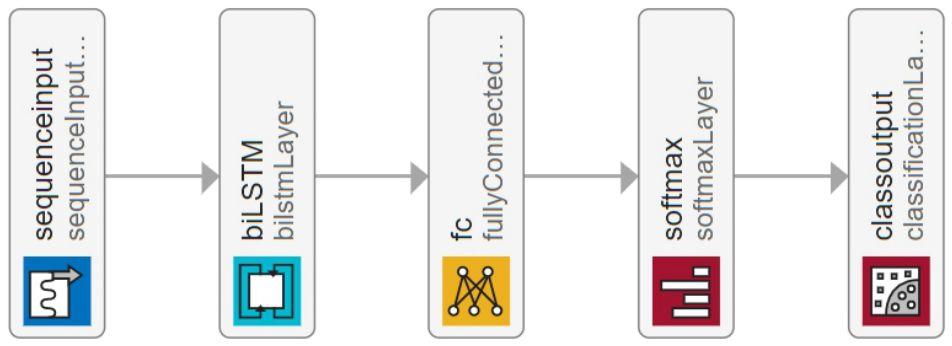
Figure 11. The LSTM Model for Data-Fusion-Centric Authentication.